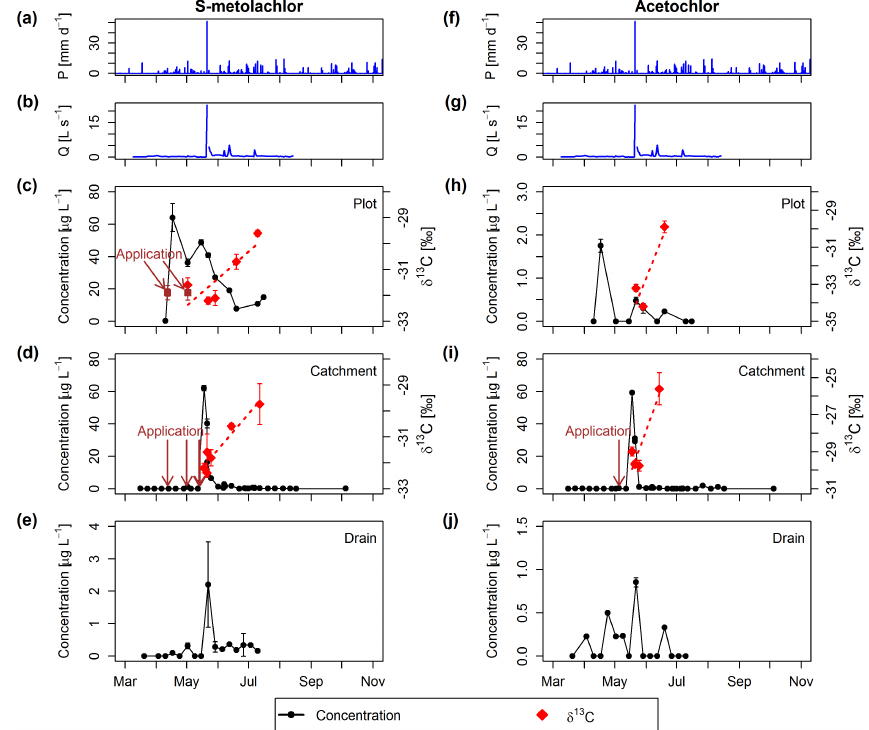
Figure 3. Measured precipitation ( P , a , f ), discharge ( Q , b , g ), concentrations (black dots), and δ 13 C values (red diamonds) of S-metolachlor (left panels) and acetochlor (right panels) at the plot (c, h) , catchment outlet (d, i) , and drain outlet (e, j) . SDs of replicate measurements are indicated by vertical error bars. Linear regression of δ 13 C values is shown as dashed red lines (coefficients of determination: R 2 = 0 . 70 c , R 2 = 0 . 92 d , R 2 = 0 . 80 h , and R 2 = 0 . 86 i ). Dates of reported pesticide application in the study catchment are indicated in brown (including the δ 13 C values of the applied pesticide in the plot experiment in c